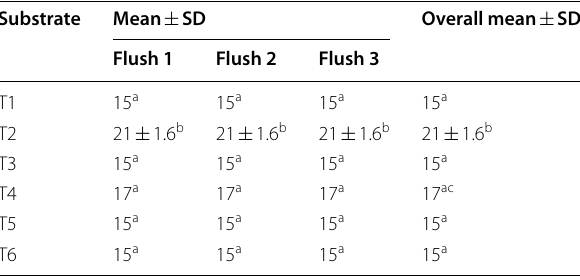
Table 2 The effect of substrates on mycelium colonization period (days)